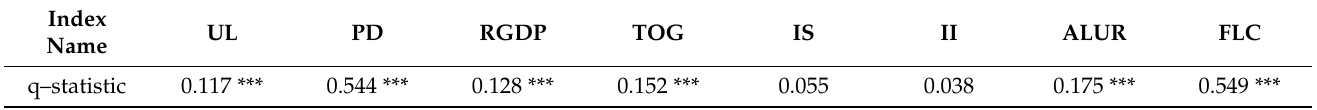
Table 4. Geodetector factorial detection results.